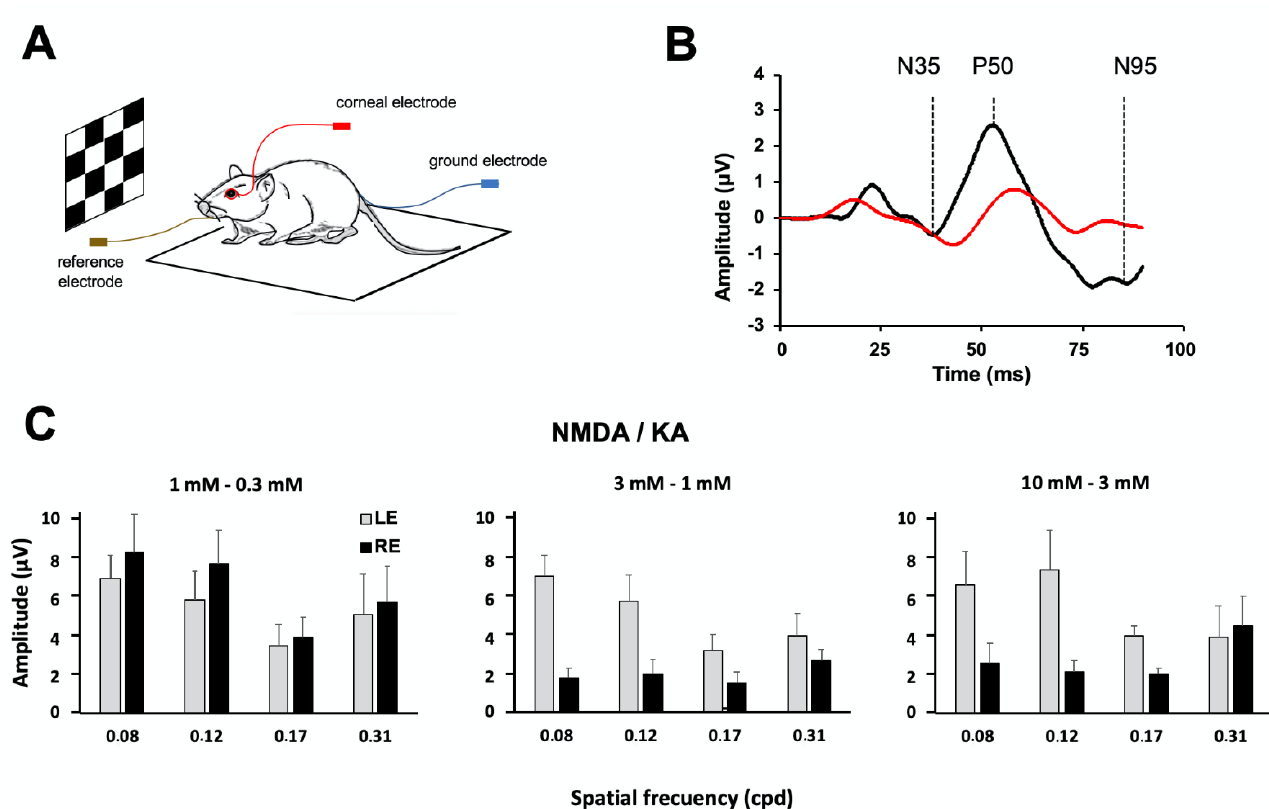
Figure 7. Effect of NMDA/KA injection on retinal ganglion cell functionality evaluated by pattern electroretinography (pERG). ( A ). Schematic diagram of the pERG test experimental design ( B ). Example of the pERG trace recorded before the injection of 10:3 mM NMDA/KA (black line) and one week after the injection (red line). Before injection, the trace recording shows the three characteristic components of the pERG (N35, P50, and N95). However, one week after the injection, just the P50 component is clearly distinguished. ( C ). Histogram representations of the N95 pERG component amplitude, averaged (mean ± SD) from the right eye (RE) and the left eye (LE) at different spatial frequencies. The right eyes of the animals are injected with NMDA/KA at 1:0.3 mM ( n = 7), 3:1 mM ( n = 7) and 10:3 mM ( n = 4). The control left eyes are injected with PBS. A statistically significant decrease in the N95 amplitude is observed after eye injection with 3:1 mM and 10:3 mM NMDA/KA ( p < 0.05, two way ANOVA).